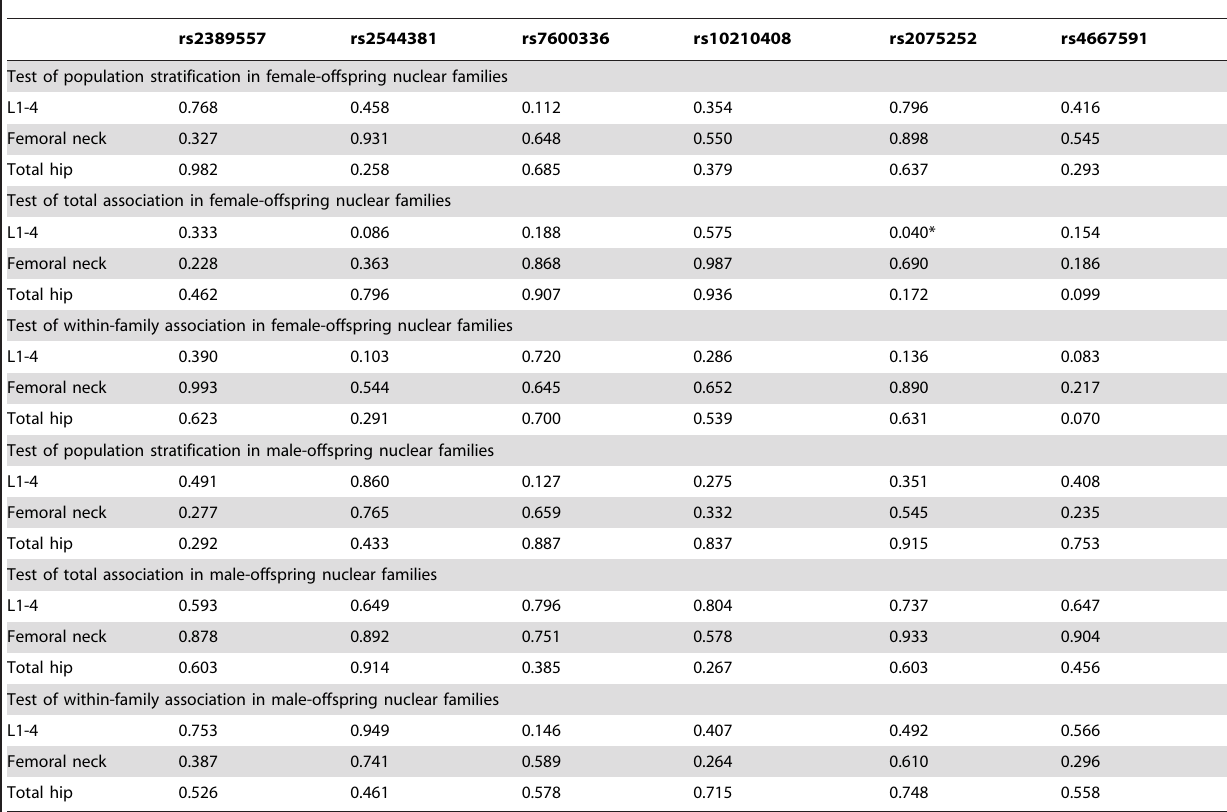
Table 3. P values obtained for analyses of population stratification, total association and within-family association for six